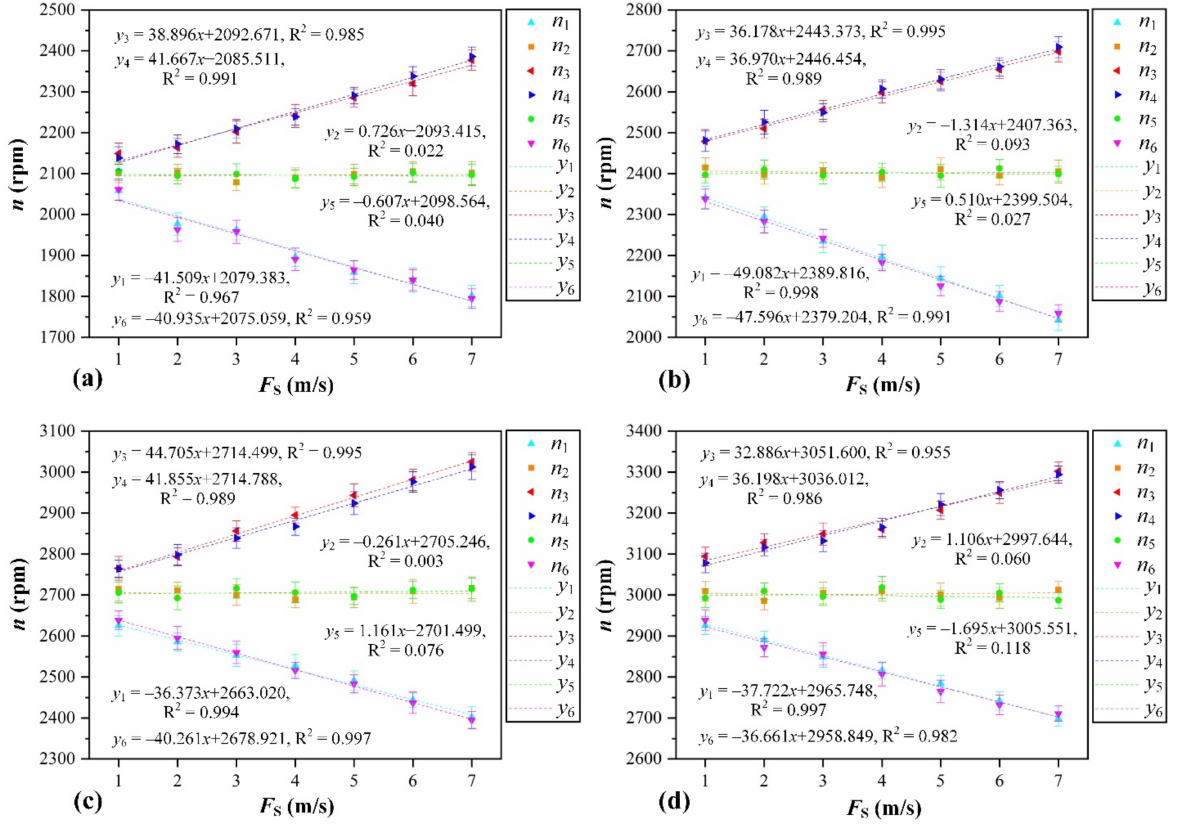
Figure 10. Mean values of measured rotor speed in forward flight of the UAV sprayer ( F A = 3 m). ( a ) L G = 4 kg; ( b ) L G = 8 kg; ( c ) L G = 12 kg; ( d ) L G = 16 kg. The mean ± standard deviation of the rotor speed and the results of linear regression are presented at each treatment with different loads ( L G = 4, 8, 12, and 16 kg) and flight speeds ( F S = 1 − 7 m s − 1